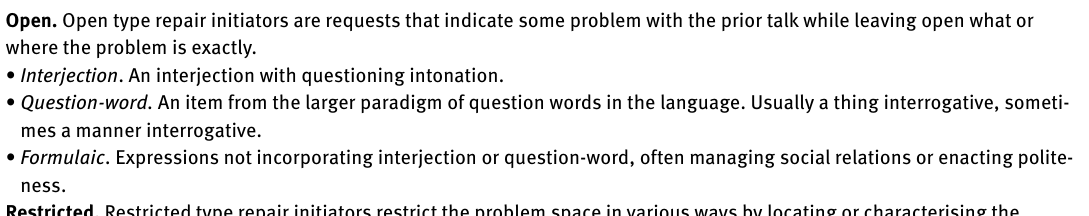
Table 2: Some basic format types for other-initiation of